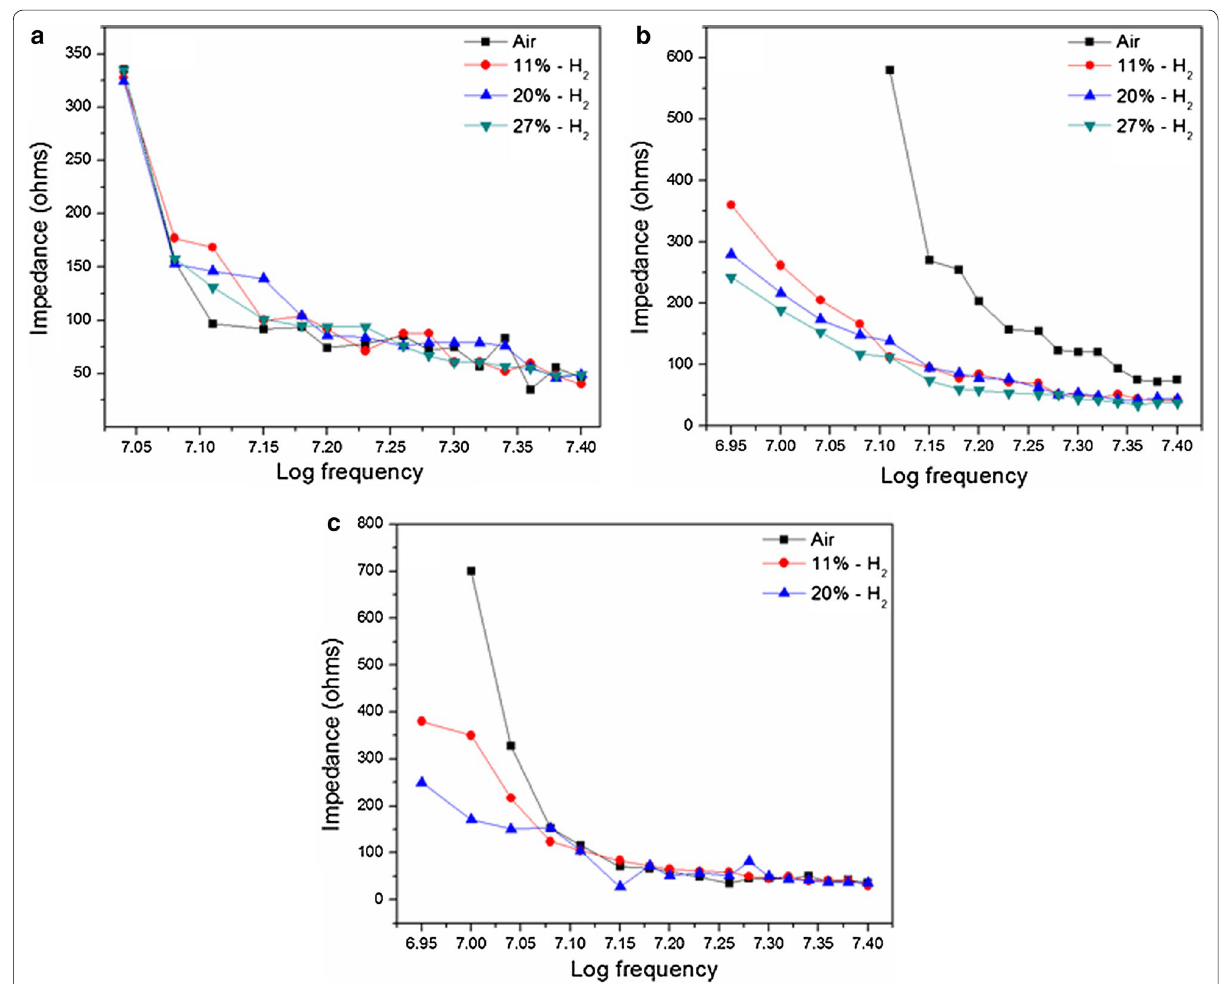
Fig. 13 Capacitive behavior of a PAni film, b Pd incorporated PAni film and c Pd only for H 2 sensing